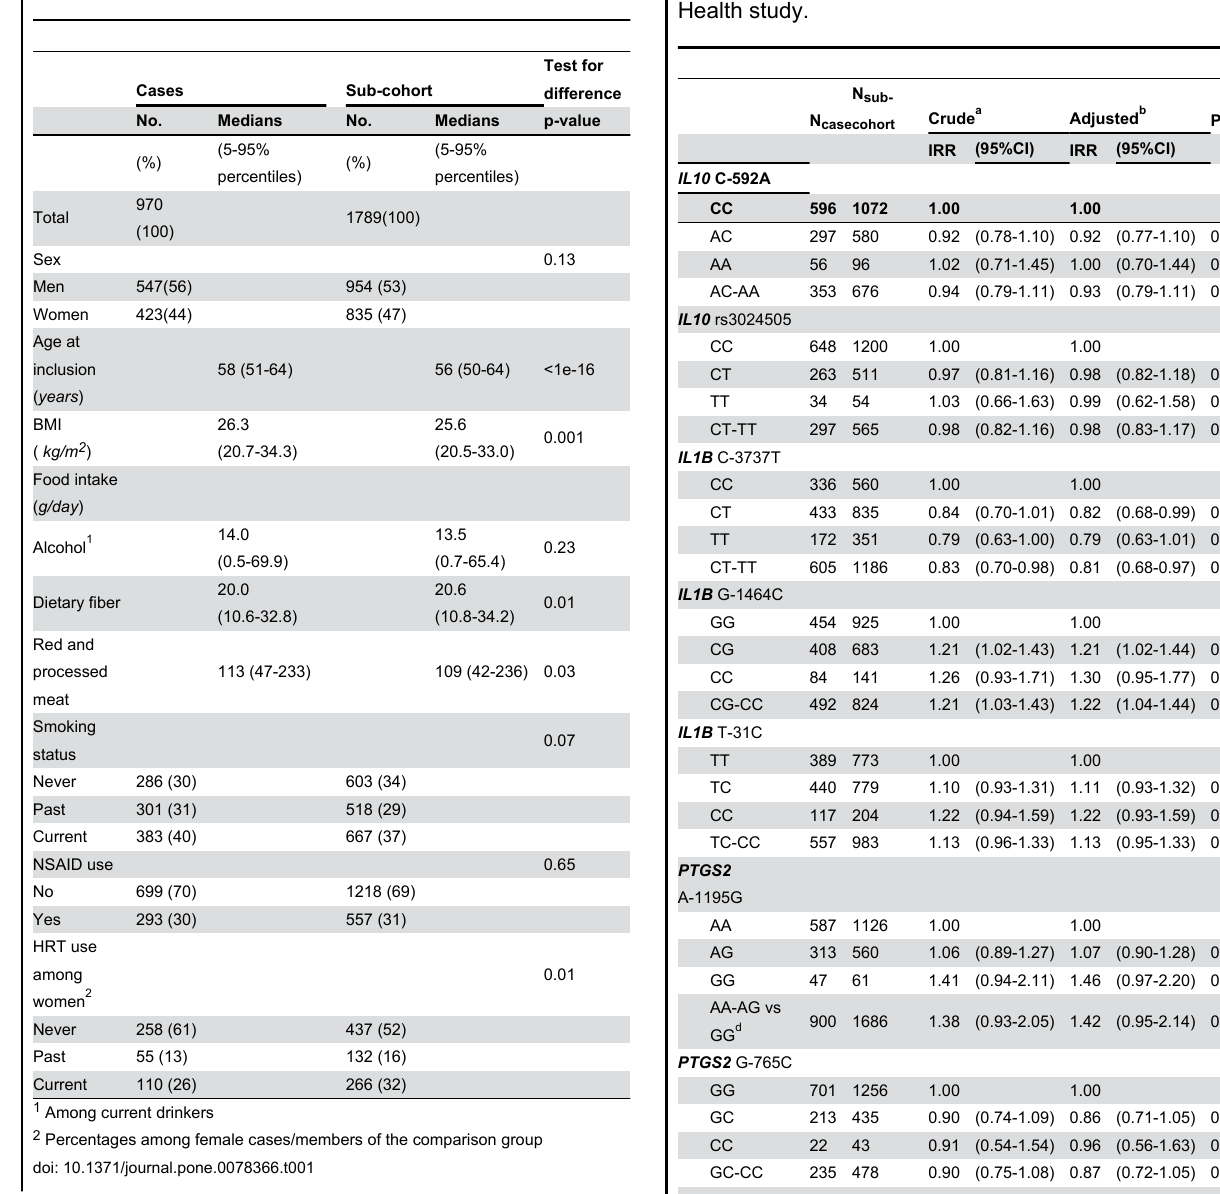
Table 1. Baseline characteristics of study population selected for the Diet, Cancer and Health cohort.